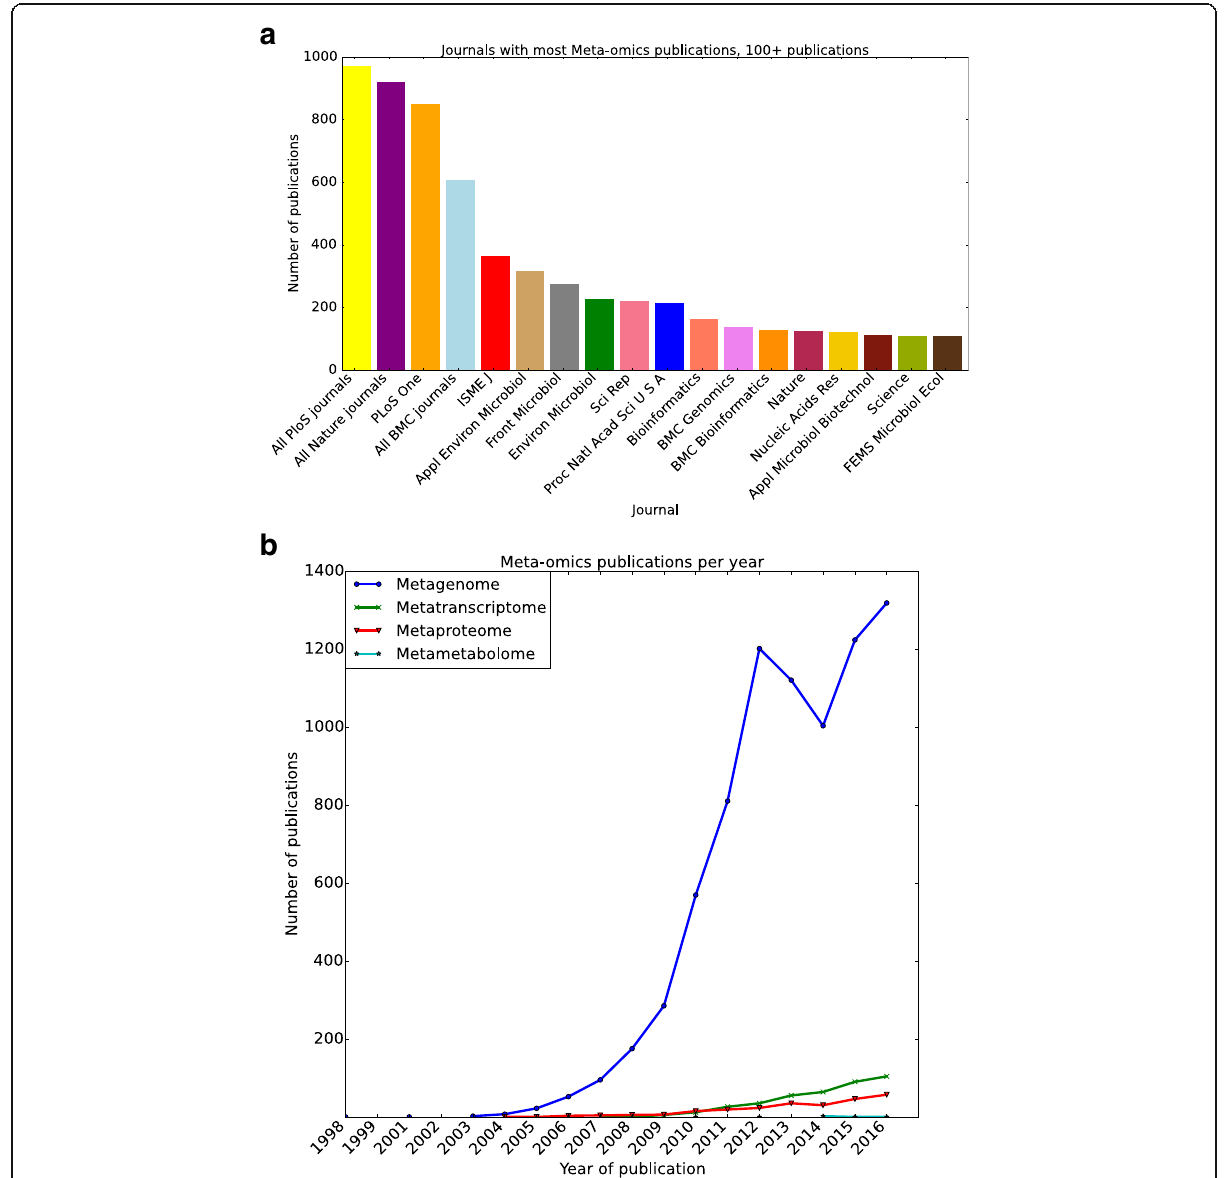
Fig. 2 a Journals with the most gut-related meta-omics publications. b Overview of gut-related omics publications per year. 16S rRNA gene sequencing and metagenomics are combined, since these cannot be easily distinguished via title/abstract searches due to the erroneous labelling of amplicon sequencing approaches as metagenomics by many researchers. All data was retrieved via PubMed searches for the corresponding terms. For the exact search terms, please see Additional file